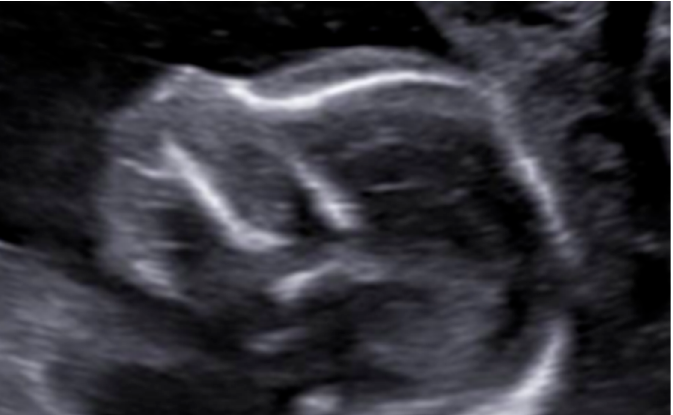
Figure 5. Sagittal section of the fetal profile, where nasal bone, prefrontal edema and mild microg- nathia could be seen.